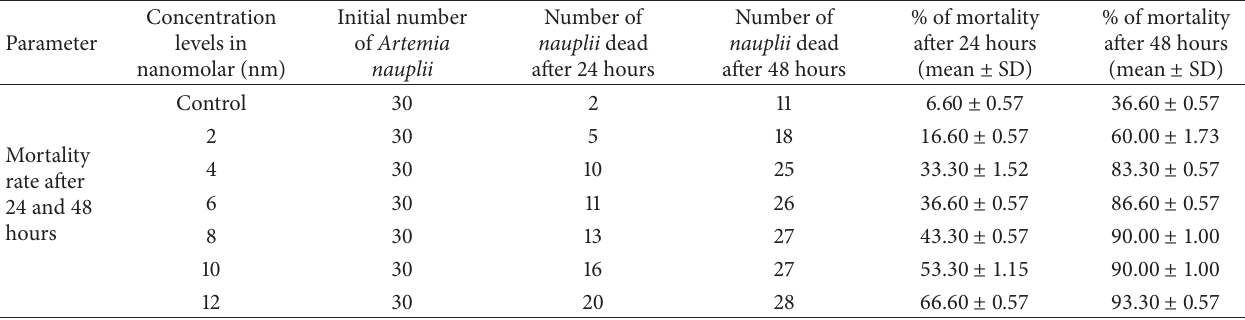
Table 1: The result for mortality rate (24 and 48 hours) of brine shrimp Artemia nauplii treated with various nanomolar concentrations of silver nanoparticles.